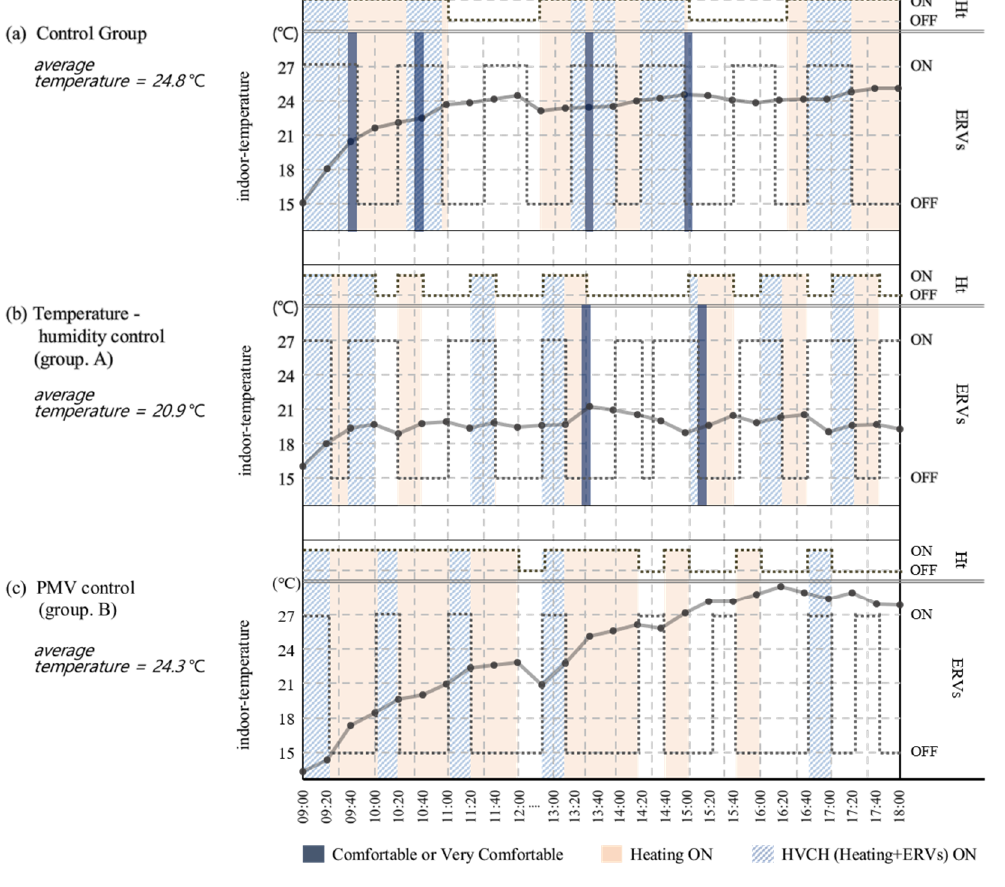
Figure 6. Comparison of the comfort levels of occupants at various heating, ventilation, and air conditioning (HVAC) operating patterns.: ( a ) results graph of the control group; ( b ) results graph of the experimental group A; ( c ) results graph of the experimental group B.